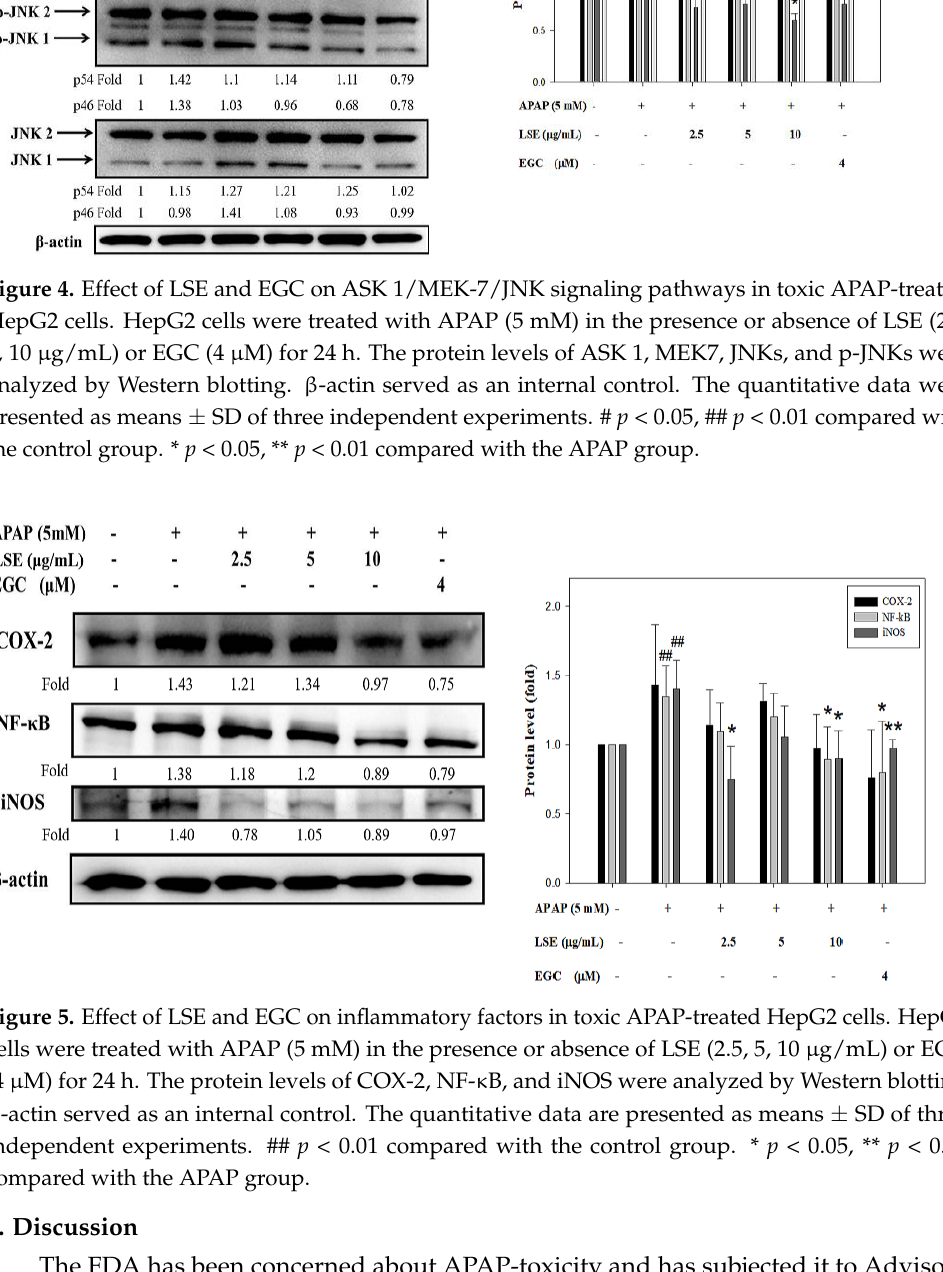
Figure 4. Effect of LSE and EGC on ASK 1/MEK-7/JNK signaling pathways in toxic APAP-treated HepG2 cells. HepG2 cells were treated with APAP (5 mM) in the presence or absence of LSE (2.5, 5, 10 µg/mL) or EGC (4 µM) for 24 h. The protein levels of ASK 1, MEK7, JNKs, and p-JNKs were analyzed by Western blotting. β -actin served as an internal control. The quantitative data were pre- sented as means ± SD of three independent experiments. # p < 0.05, ## p < 0.01 compared with the control group. * p < 0.05, ** p < 0.01 compared with the APAP group.